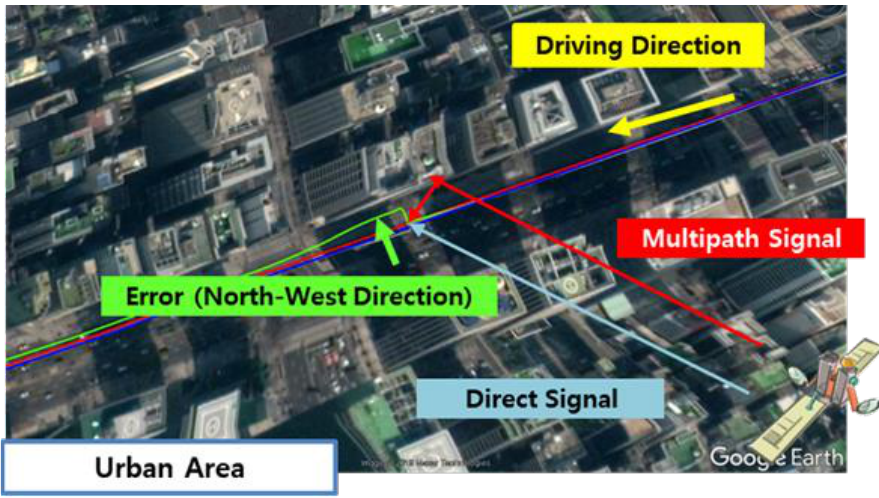
Figure 15. Horizontal trajectory on Google earth.